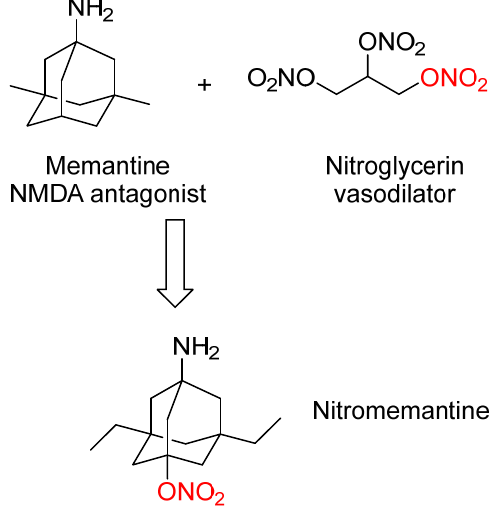
Figure 2. Design strategy leading to second generation memantine analog nitromemantine, in which the important pharmacophore (nitrooxy moiety red–ONO drug nitroglycerin was introduced into the structure of